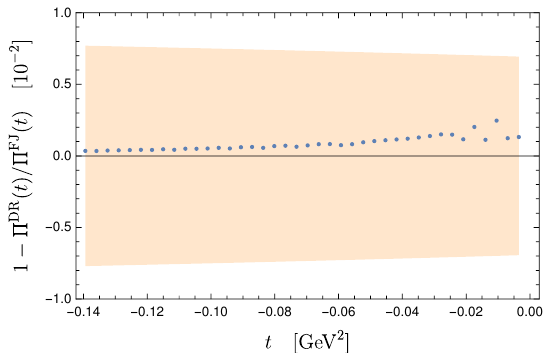
Figure 7. Blue dots are the di(cid:11)erence between the hadronic vacuum polarization provided by alphaQED , (cid:5) FJ ( t ), and the value obtained by direct integration of the dispersion relation with R ( s ) from the same library, (cid:5) DR ( t ). The orange band shows the experimental uncertainty on (cid:5) FJ ( t ). The two determinations of (cid:5) had ( q 2 ) are nevertheless in very good agreement within the experimental uncertainty on (cid:5) FJ ( q 2 ), which is also provided by alphaQED (shown by the orange band in (cid:12)gure